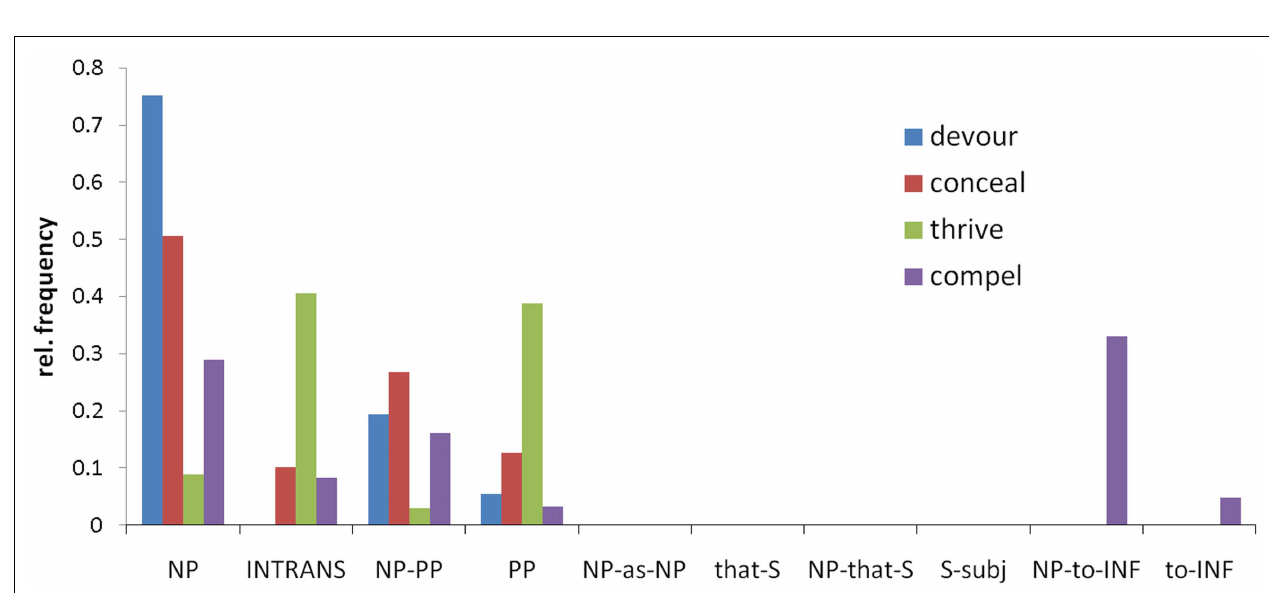
behavior. NP, noun-phrase complement (e.g., “he devoured the meal”); INTRANS, intransitive (e.g., “he thrived”); PP, prepositional phrase complement (e.g., “he thrived in school”); S, sentential complement; INF, verb